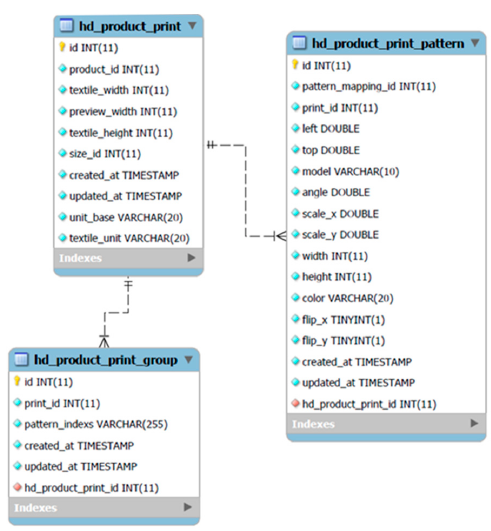
Figure 12. Development concept flow chart.